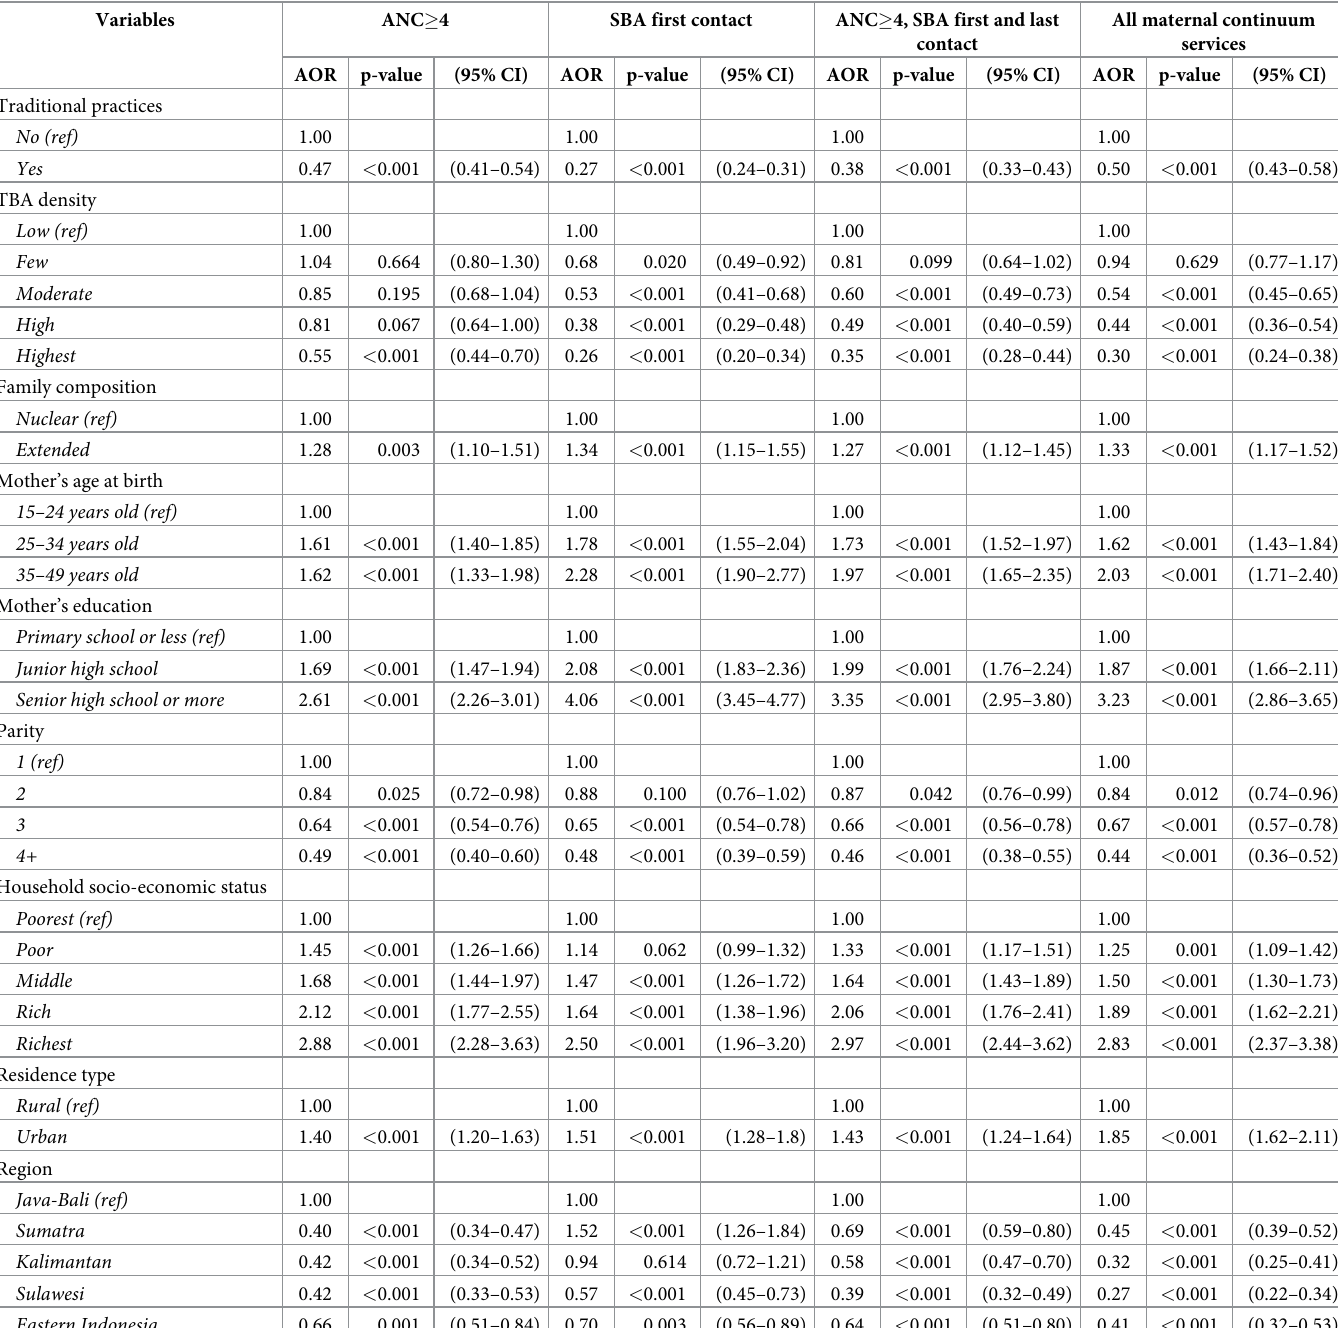
Table 3. Multivariate logistic regression of traditional practices and continuum of maternal health care